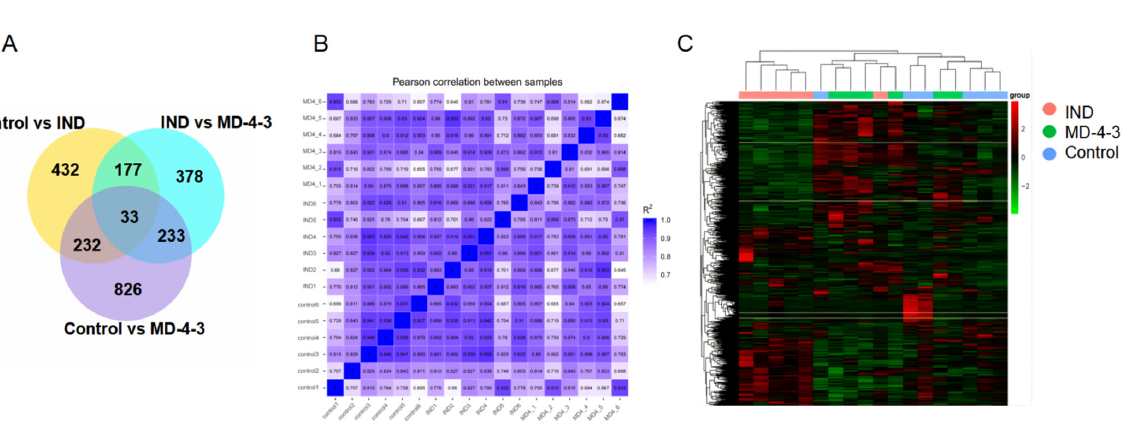
Figure 2. Transcriptomic analysis of MD-4-treated IND-induced gastric ulcerated rats. ( A ): Venn diagram shows the number of differentially expressed genes. Different colors represent different comparisons, adding all the numbers in one circle provides the number of differentially expressed genes for a particular comparisons, while overlapping areas represent common differentially ex- pressed genes when two groups were compared. ( B ): Pearson correlation heat map between sam- ples. The abscissa and ordinate are the square of the correlation coefficient of each sample. ( C ): Clus- ter heat map of genes that were differentially expressed. The abscissa indicates sample names, with the ordinate being the normalized FPKM vale. Red and green colors indicate upregulation and downregulation, respectively. ( D , E ): Volcano plots showing transcriptome data. ( A , B ): 874 and 821 genes were differentially expressed when comparing the control with IND treatment ( A ) and be- tween IND- and MD-4-treated groups ( B ), respectively. Vertical lines indicate a log2 fold change, while the horizontal ones represent p -value of 0.05. Red and green colors indicate significant up- and downregulation of genes, respectively. Significant DEGs were identified based on a p -value of <0.05 and a log2 fold change of at least 2.0. Control: normal control, IND: indomethacin, MD-4: molor-dabos-4 decoction.